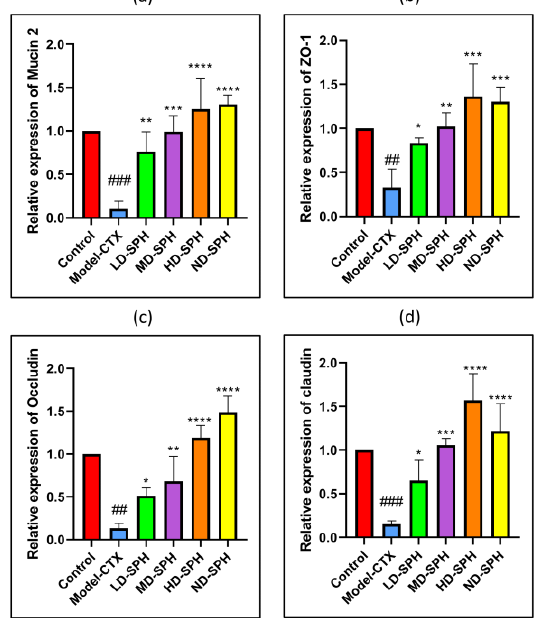
Figure 4. Relative expression of mRNA in colon tissues: ( a ) Mucin-2, ( b ) Zo-1, ( c ) Occludin, and ( d ) claudin-1, mRNA levels were standardized against Beta-actin expression, and as shown the mean ± SD fold increase compared with the control group. ### p < 0.001 comparison to the Normal control group. * p < 0.05, ** p < 0.01, *** p < 0.001, and **** p < 0.0001, comparison to the Model-CTX group.